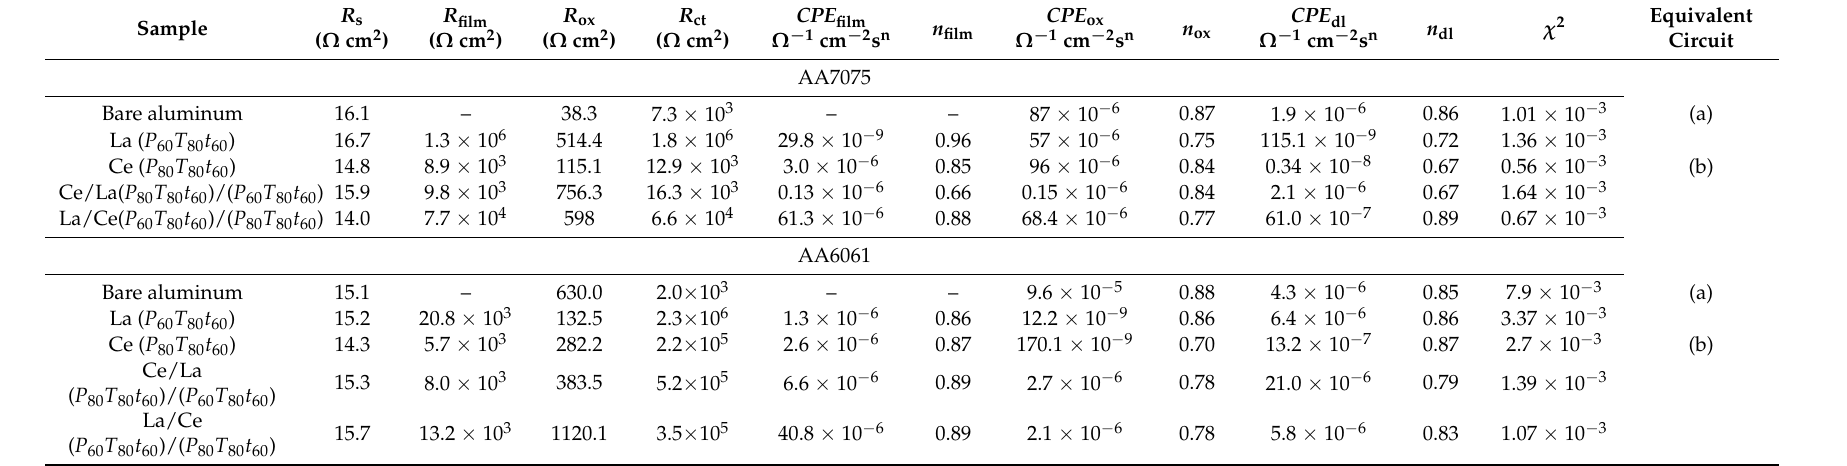
Table 4. Fitting analysis of EIS spectra with their corresponding equivalent